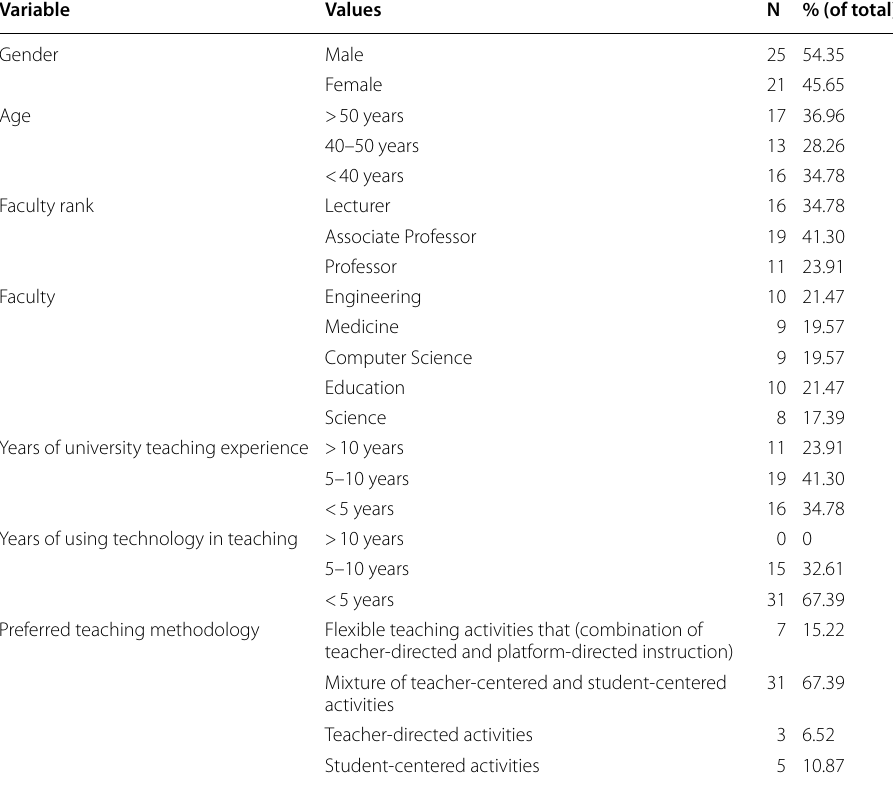
Table 2 Summary of participants’ demographic and professional characteristics